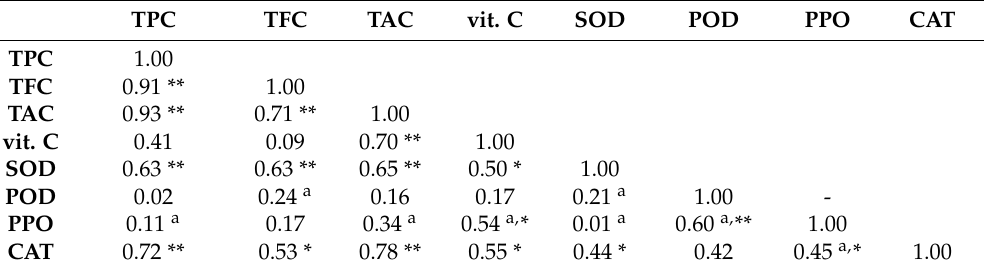
Table 3. Correlation between the total phenolic content (TPC), total flavonoid content (TFC), total anthocyanin content (TAC), vitamin C content (vit. C), superoxide dismutase activity (SOD), peroxidase activity (POD), polyphenol oxidase activity (PPO) and catalase activity (CAT).